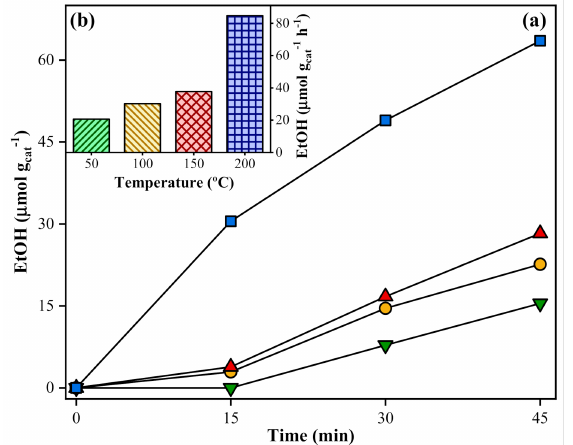
Figure 7. Evolution of the ( a ) ethanol production from CO 2 and C 2 H 6 as a function of photoreaction’s time and the respective ( b ) reaction rate (for the maximum production), at 50 ◦ C ( ); 100 ◦ C ( ); 150 ◦ C ( ), and 200 ◦ C ( ). Experimental conditions: 20 mg of SrTiO 3 :RuO 2 :NiO; [Ru]:[Ni] = 1:1 (molar); Ru = 0.8 wt. %; P C = 1.01 bar; P CO = 0.35 bar; and I = 1000 W m − 2 2 H 6 2